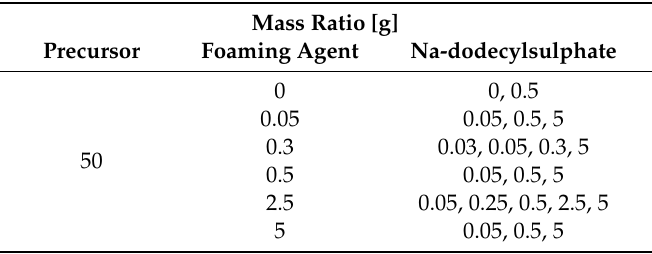
Table 2. Mass% of the foaming agents (Al, H 2 O 2 , Na-perborate), stabilizing agent (Na-dodecylsulphate), and precursor. Variations were used according to the success of experimental work mostly depending on the foaming agent e ff